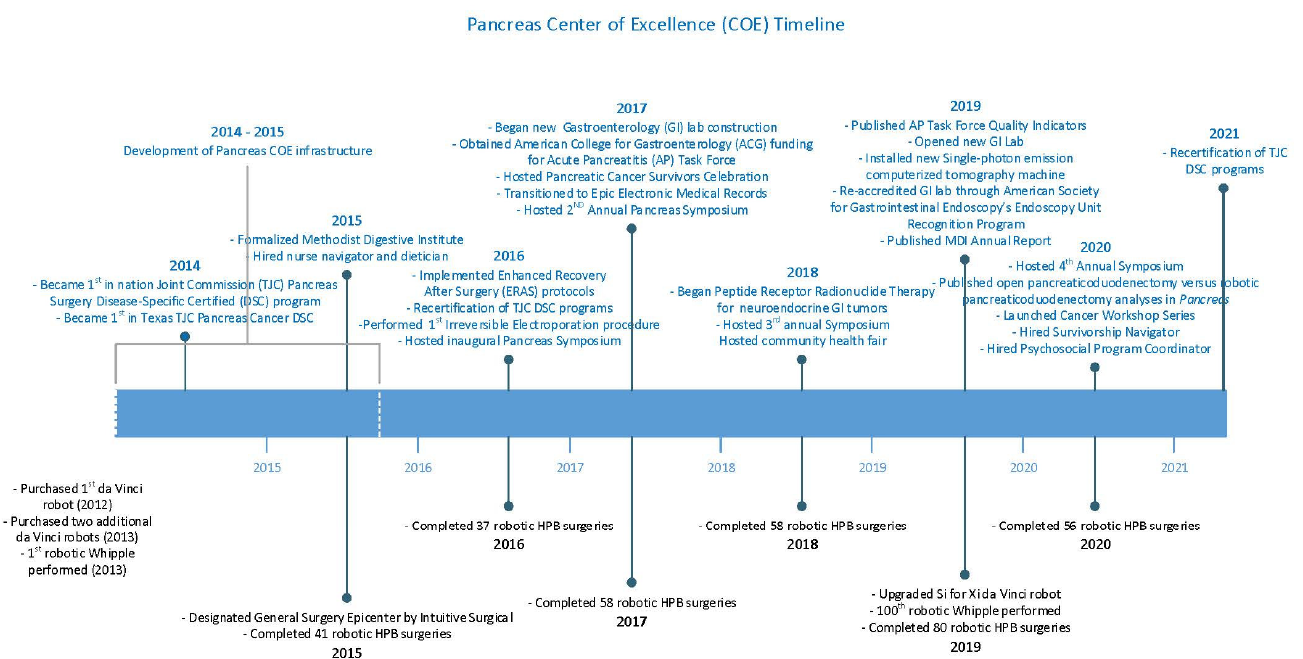
Figure 3. Pancreas CoE development timeline and major